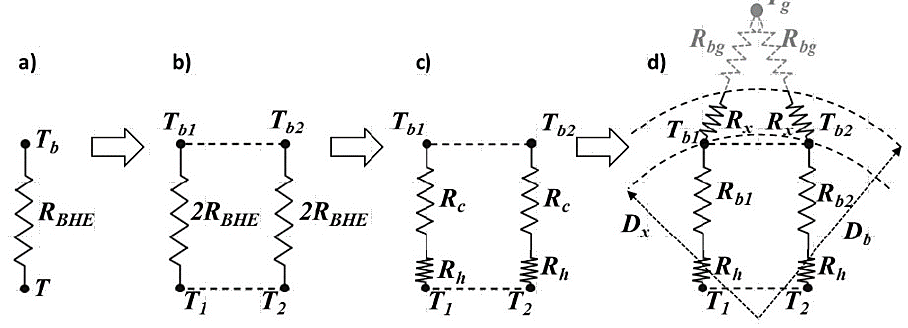
Figure 3. Thermal resistances definition steps: ( a ) borehole resistance, ( b ) parallel borehole resistances, ( c ) convective and conductive resistances and ( d ) final resistances configuration (reproduced from [22]. Copyright Elsevier, 2014).